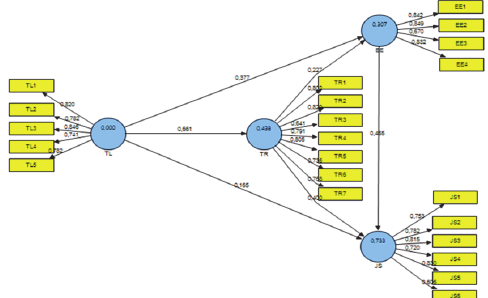
Fig. 1. The results of the implementation of Inner model